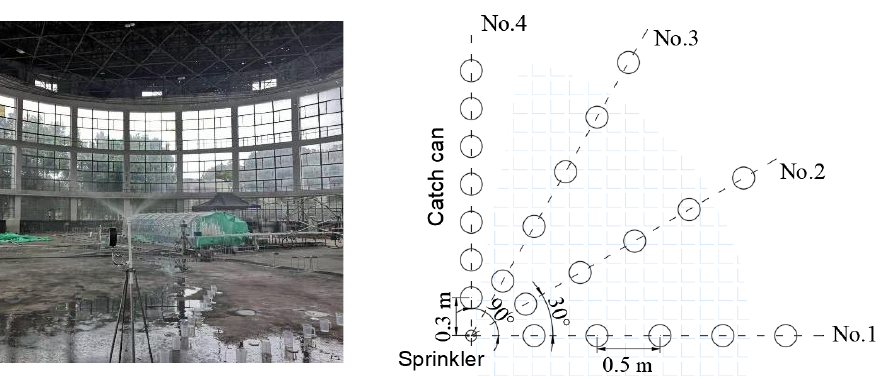
Figure 2. Irrigation experiment system diagram